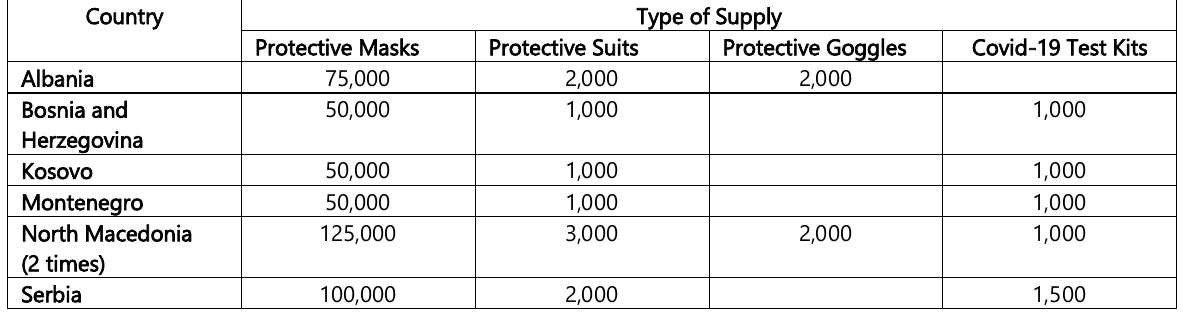
Table 4: Covid-19 Medical Supplies Sent by Turkey to the Western Balkans (March-May